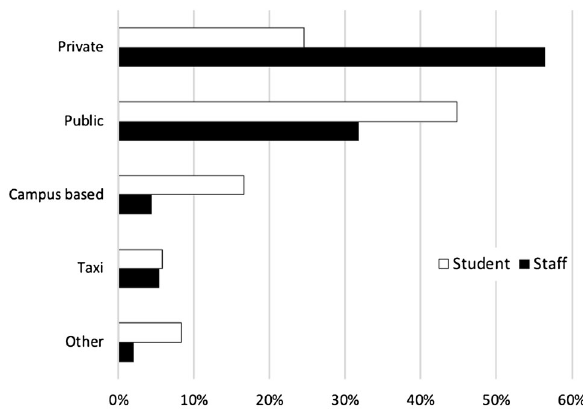
Fig. 3 Respondents’ primary commute